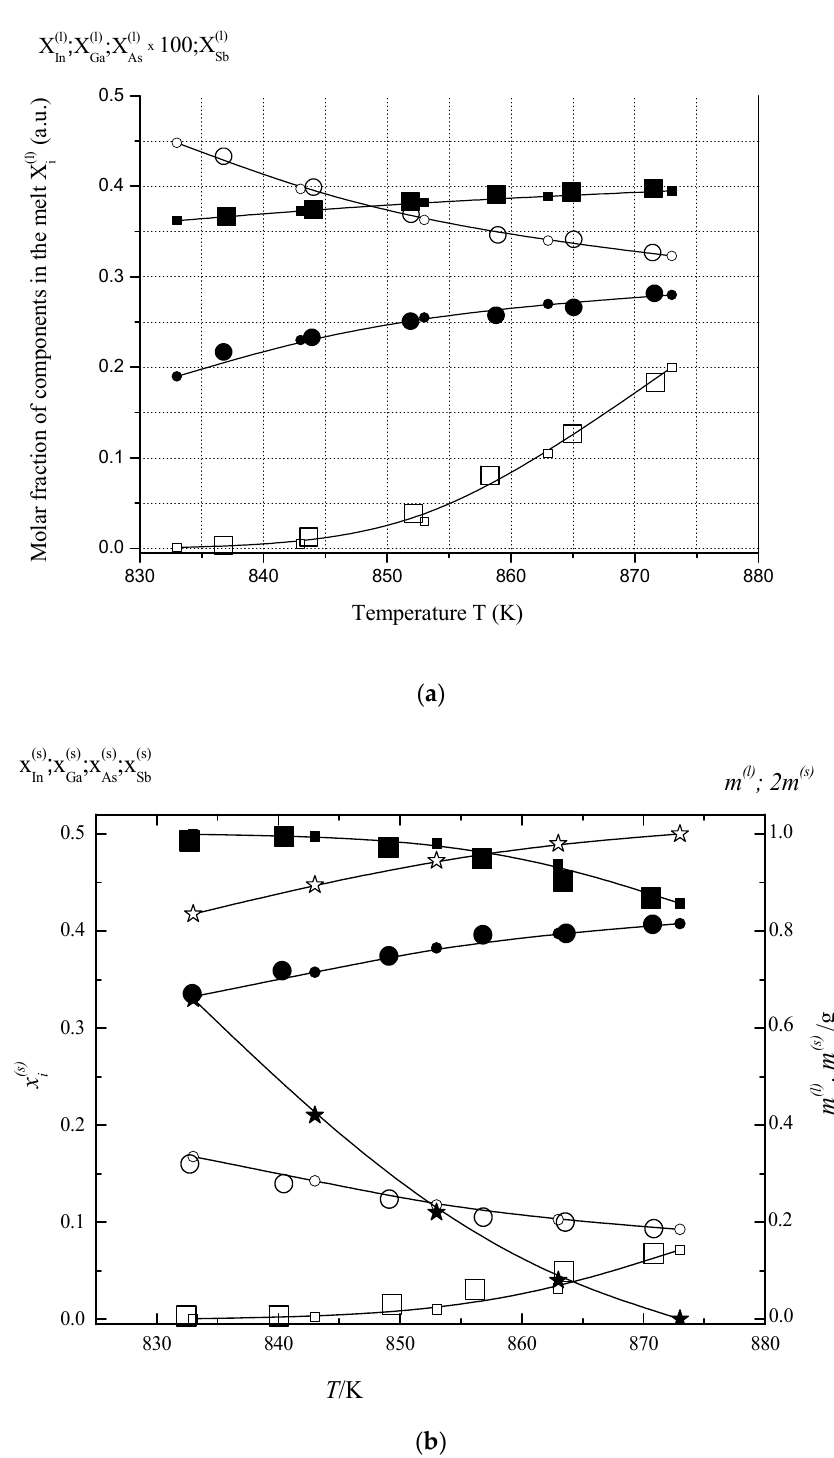
Figure 1. Temperature dependences of liquid ( a ) and solid ( b ) phases compositions in the In-Ga-As-Sb system: In, ○ ; Ga, ● ; As, □ ; Sb, ■ ; little points, calculation; large points, experimental data [18]; masses of equilibrium melt and solid solution, m ( l ) and m ( s ) ( ☆ and ★ in ( a )). Conditions of experiment: initial crystallization temperature T s = 873 K, final crystallization temperature T f = 833 K; initial melt mass m ( l )0 = 1.0035 g; substrate ( GaSb ) area S = 1.01 cm 2 .